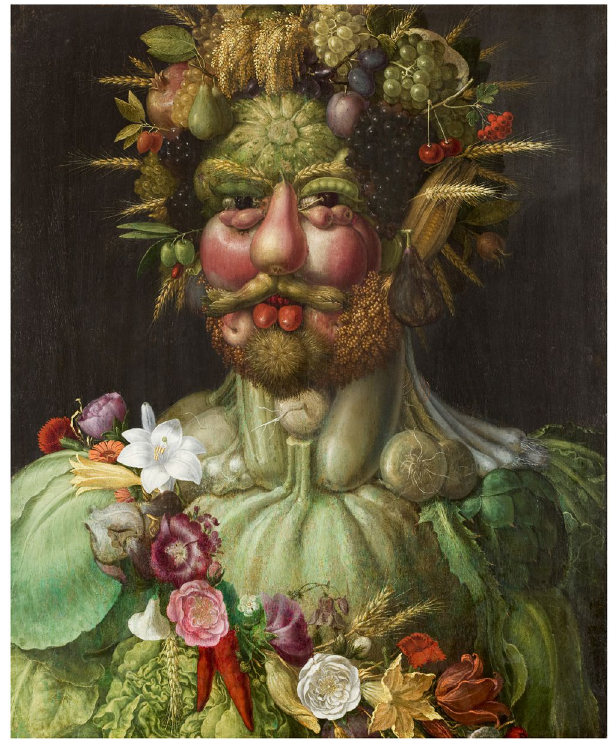
Figure 1. Example of the Giuseppe Arcimboldo style. The painting ‘Vertumnus’ by Guiseppe Arcimboldo (1526–1593), an Italian painter best known for creating fascinating imaginative portraits composed entirely of fruits, vegetables, plants, and flowers, depicts the Holy Roman emperor Rudolf II as Vertumnus, the Roman God of metamorphoses (http://vangoyourself.com/paintings/vertumnus; public domain